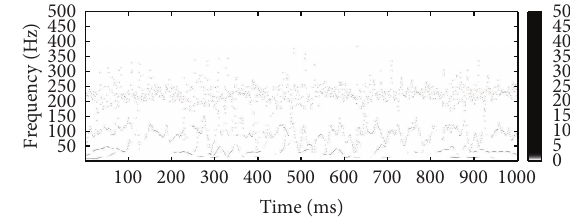
Figure 22: Intensity matrix of bearing cages fault signal.